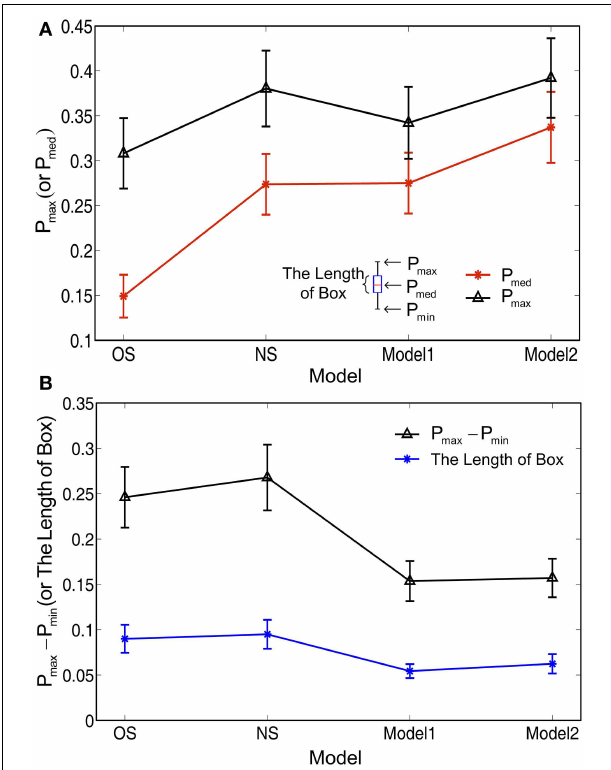
FIGURE 8 | Full statistical comparison of different models. (A) The statistics of the max P ( P max ) and median P ( P med ) of the Box-and-Whisker statistics as shown in Figure 7 . (B) The statistics of the length of whiskers ( P max − P min ) and the length of boxes. The statistics shown in (A,B) were computed on the Box-and-Whisker statistics of all the 40 images of the whole RuG dataset. The error bars indicate 95% confidence